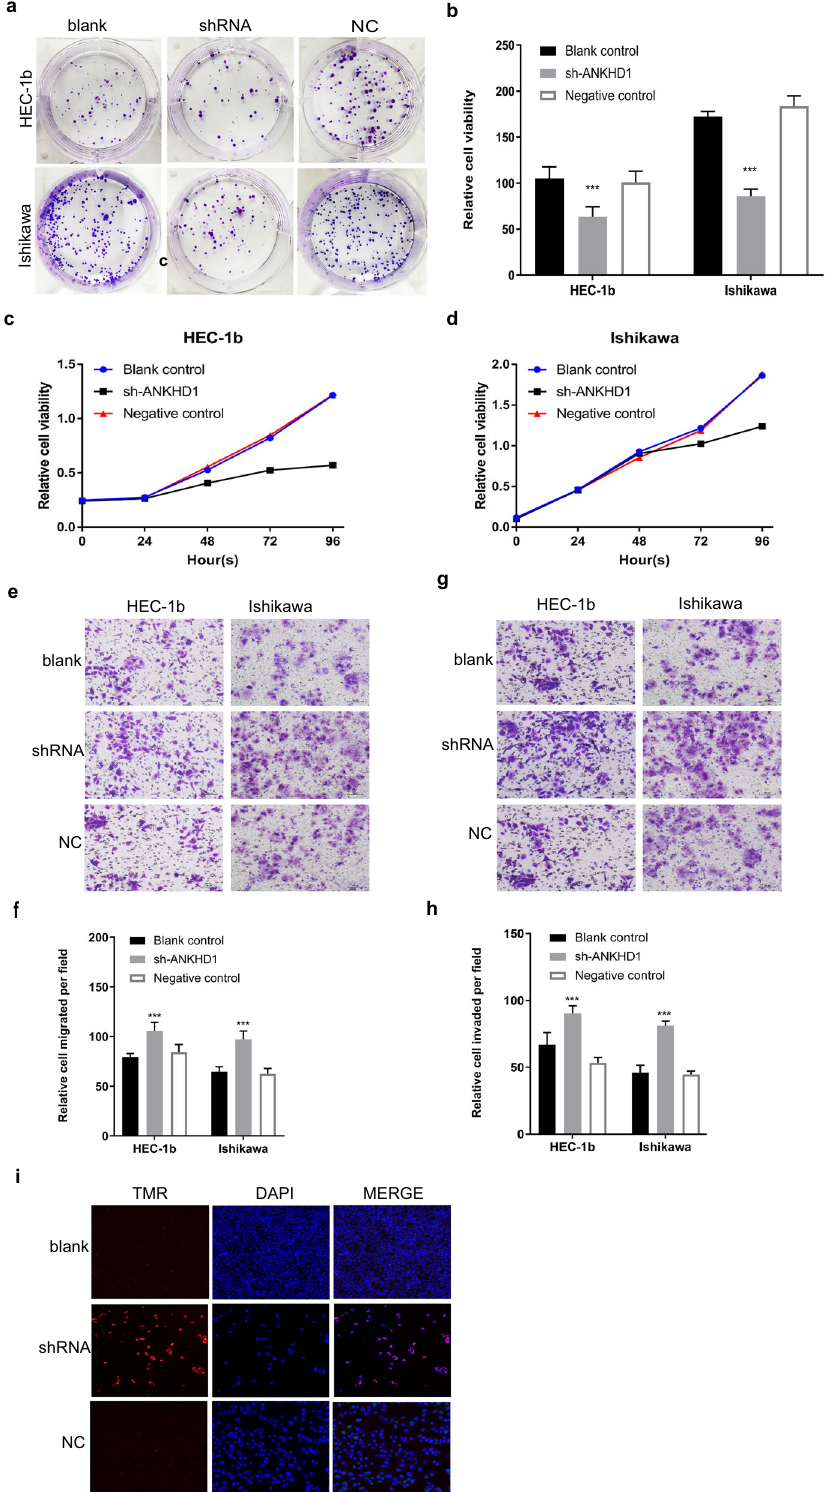
Fig. 6 Loss of function experiment in vitro. The plate clone formation assay ( a , b ), CCK-8 assay ( c , d ), migration assay ( e , f ), invasion assay ( g , h ), and Tunel results ( i ) of blank, shRNA, and NC group. *** p < 0.001. Data shown are the mean ± SD of at least three independent experiments. Data shown are the mean ± SD of at least three independent